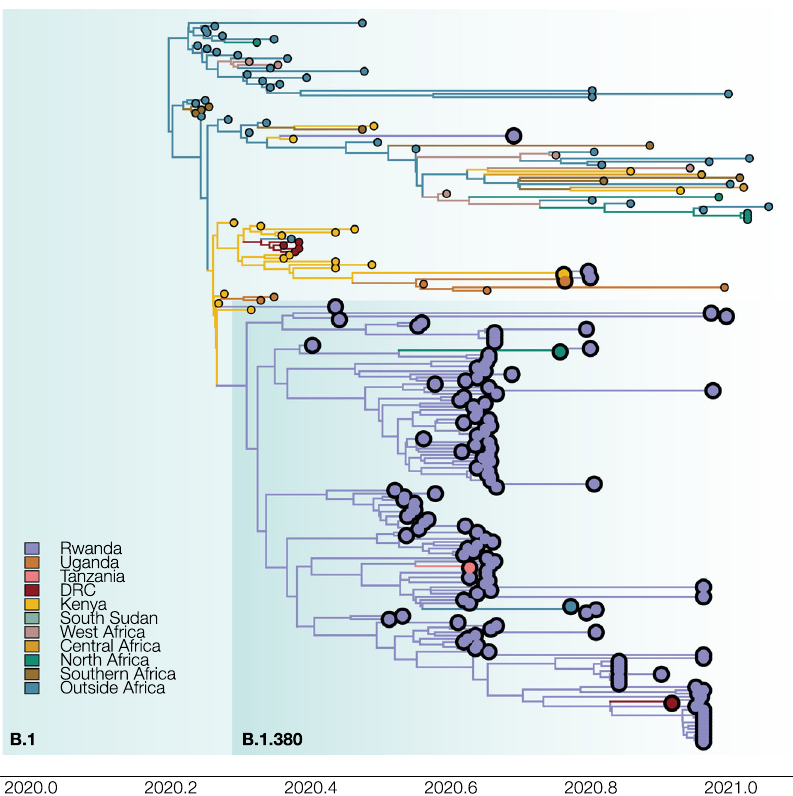
Fig. 6 Maximum clade credibility tree for subtree B.1, which includes Rwandan lineage B.1.380. The phylogeny with associated ancestral locations was inferred using travel history aware asymmetric discrete state phylogeographic inference. A total of 37 locations were considered in the analysis. The branches in the phylogeny are colored according to the geographical location of the reconstructed ancestral regions. Rwandan sequences are indicated as large tips, colo red by their associated travel histories. A total of six Rwandan sequences with associated travel history are highlighted in this subtree. The travel history-aware phylogeographic reconstruction on subtree B.1 infers a large local transmission cluster in Rwanda (subtree B.1.380). However, by incorporating individual travel histories into the phylogeographic reconstruction, we are able to infer that this subtree does not solely represent local transmission, but also introduction events into Rwanda from Tanzania, Morocco, South Sudan, and the Democratic Republic of the Congo.